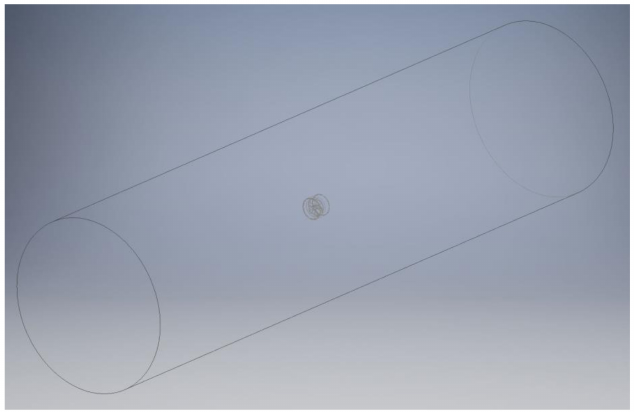
Figure 3. 3D geometry of a closed cylindrical CFD domain (LIVT duct).